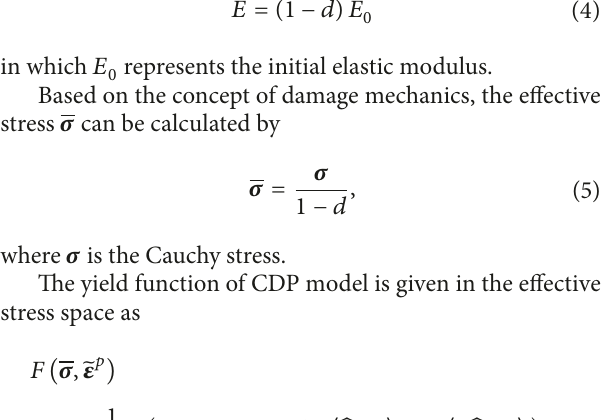
where 𝑠 𝑡 and 𝑠 𝑐 are functions of the stress state that are introduced to represent stiffness recovery effects associated with stress reversals (see [27] for more